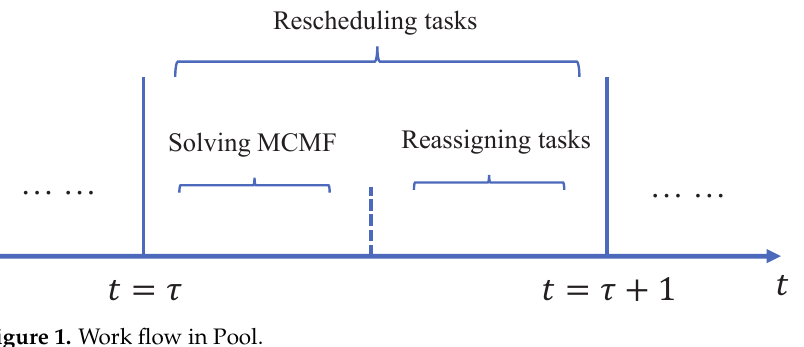
Figure 1. Work flow in